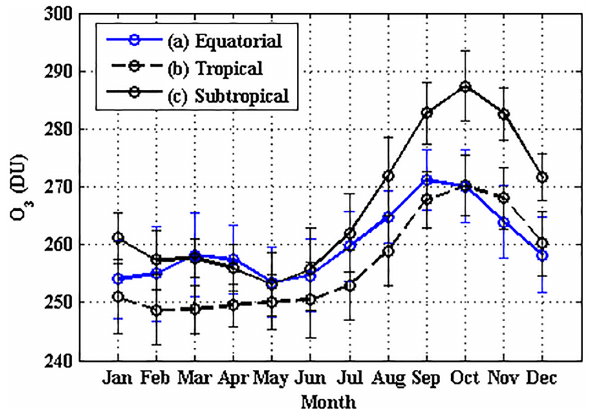
Figure 6. Vertical profiles of R 2 (determination coefficient) cal- culated by the Trend-Run model for the selected latitude range: (a) equatorial, (b) tropical and (c) subtropical regions.